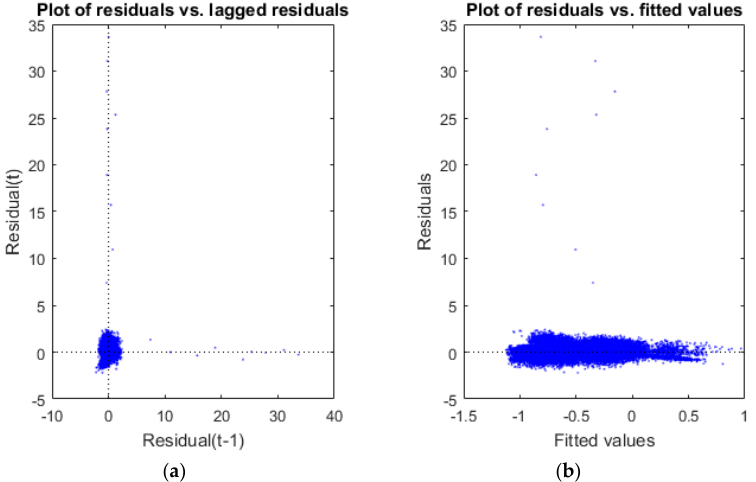
Figure 6. Scatter plot of residuals. ( a ) Residuals versus lagged residuals. ( b ) Residuals versus fitted values.